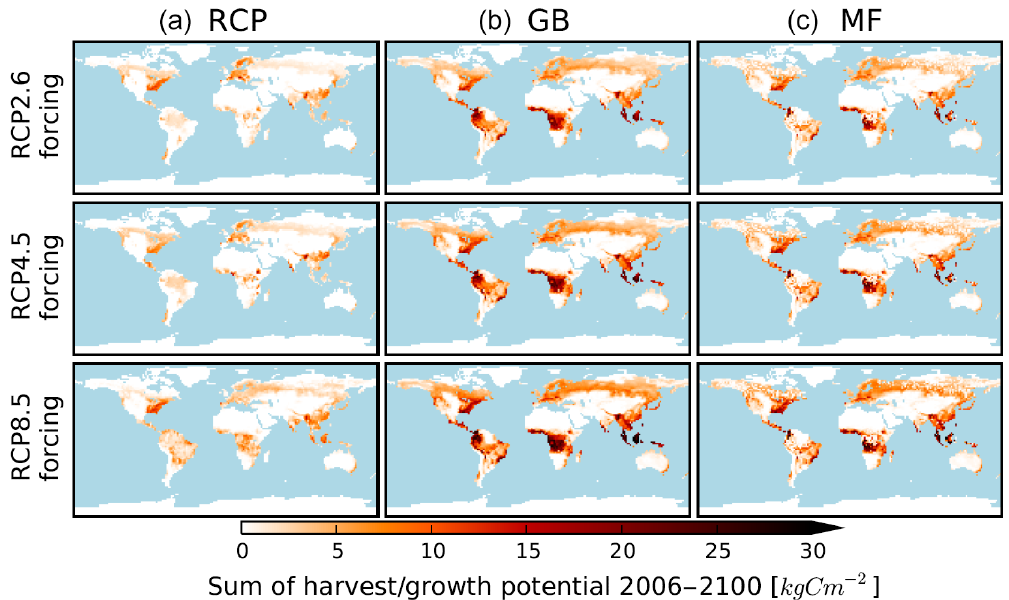
Figure 2. Spatial distribution of the harvest realized in JSBACH when harvest rates are prescribed from the Representative Concentration Pathways ( a ), for the growth-based harvest potential ( b ), and for the growth-based harvest restricted to the managed forest area ( c ). All values are summed over the entire simulated period